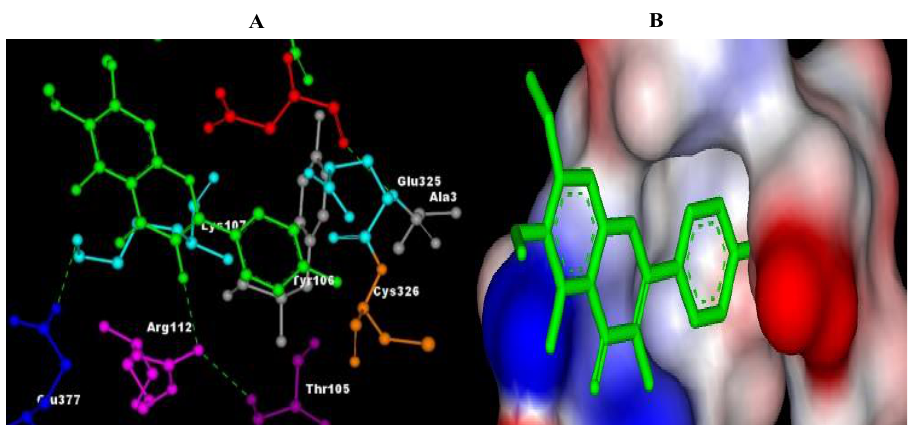
Figure 3. Pictorial representation of molecular docking analysis. ( A ) Binding orientation in the docked complex of CR with Eupalitin. ( B ) Surface representation of the CR binding pocket with the Eupalitin. The compound Eupalitin is represented in green. Images were generated using Discovery Studio visualizer.